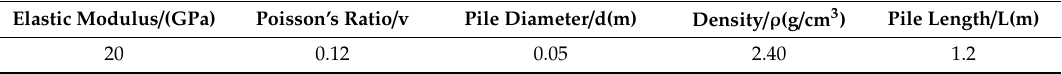
Table 2. The model pile’s calculation parameters.